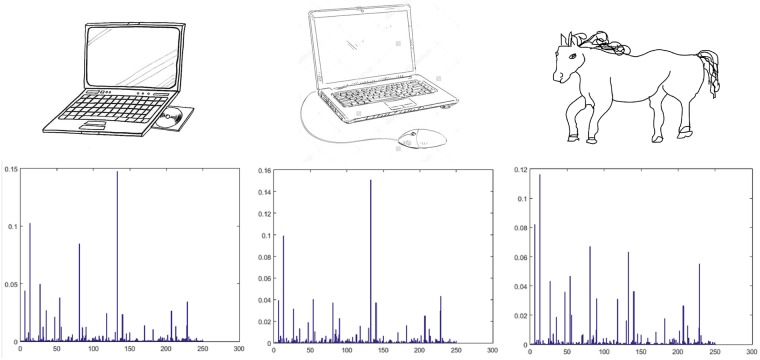
Sketch representation with deep features.